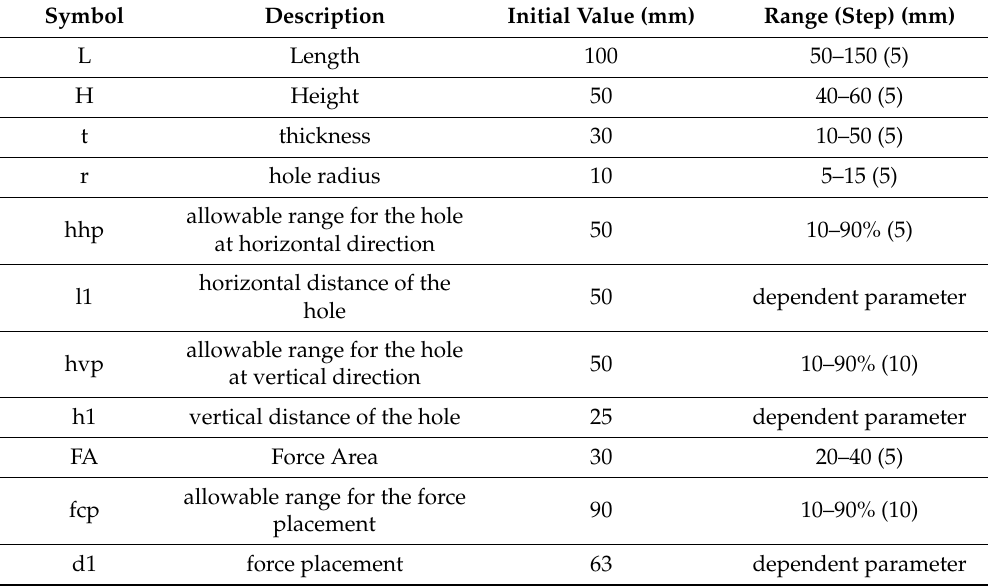
Table 2. The used design parameters (factors) in the optimization of the hollow plate, their description, initial value, allowable range, and value increment (step) in parentheses.